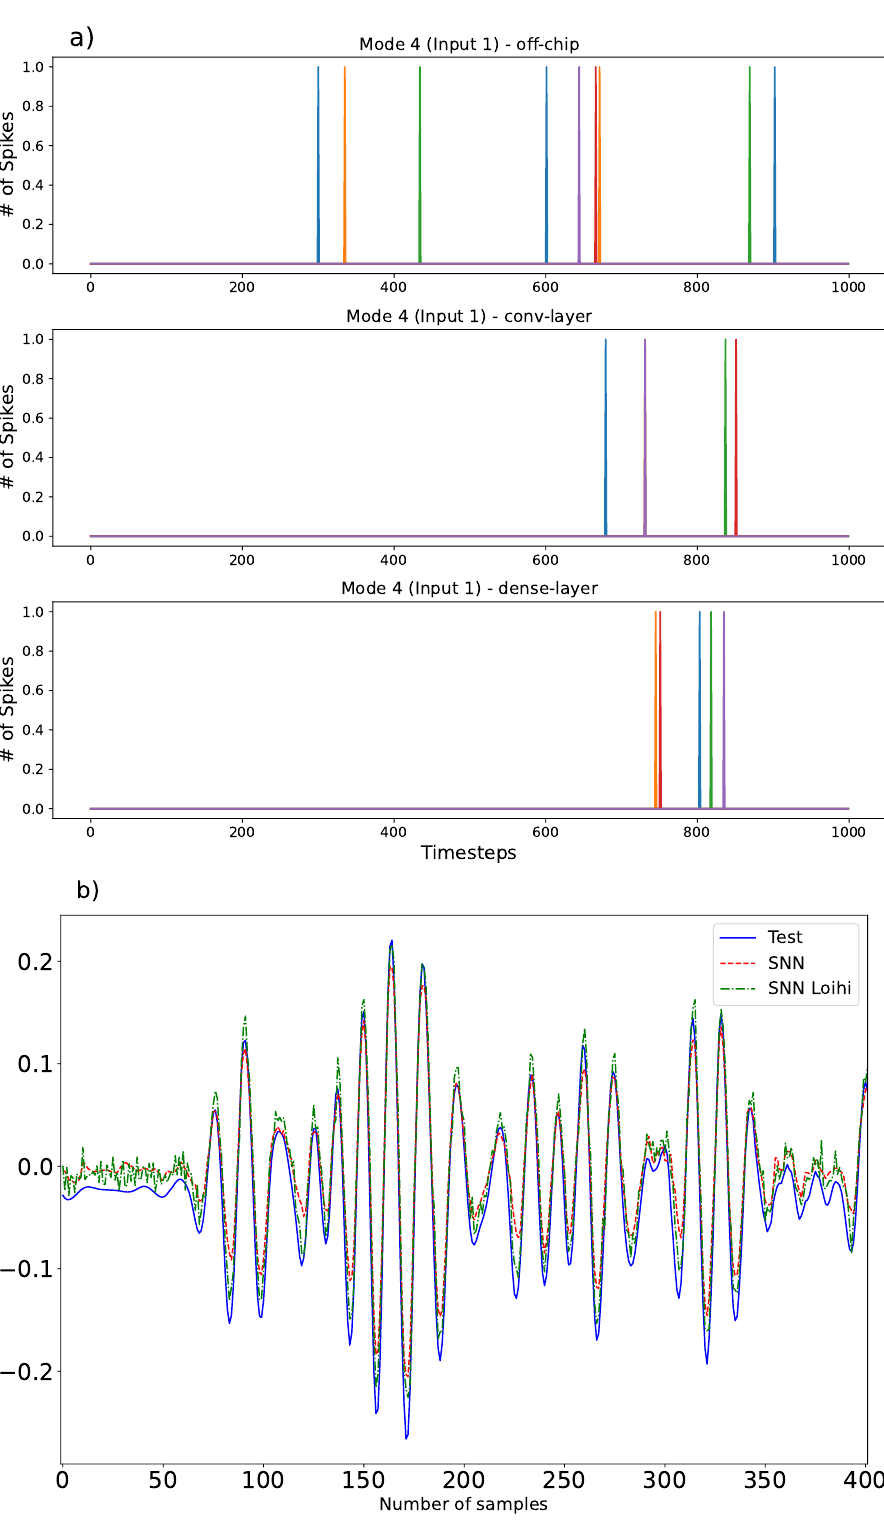
Figure 10. Results for mode 4: ( a ) Neural activities of 5 neurons of each layer. One input vector is shown over 1000 timesteps. ( b ) Predictions over the testing set with the SNN architecture (dashed red line) and running the SNN on the Loihi emulator (dash-dot green